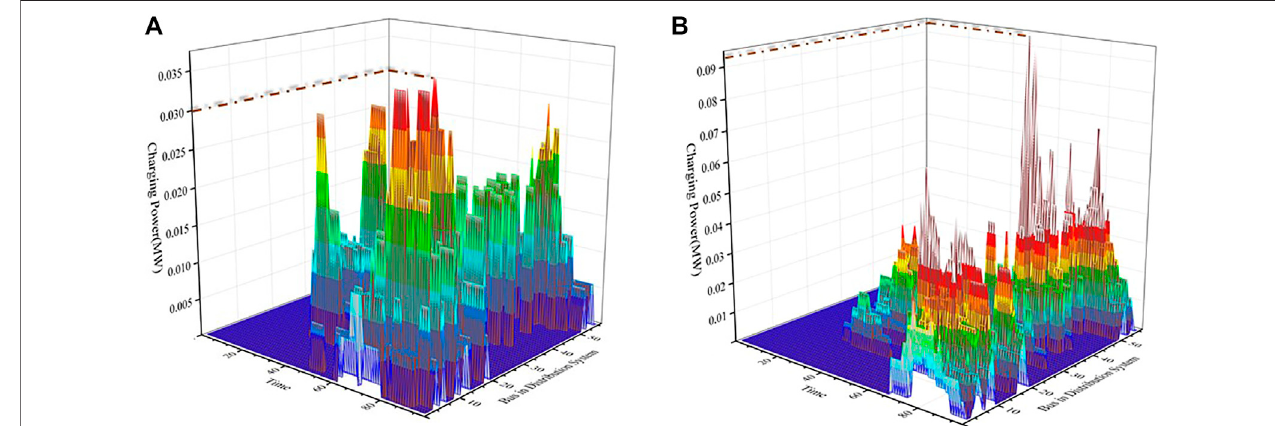
FIGURE 5 | Daily EV charging load in resting and working day.